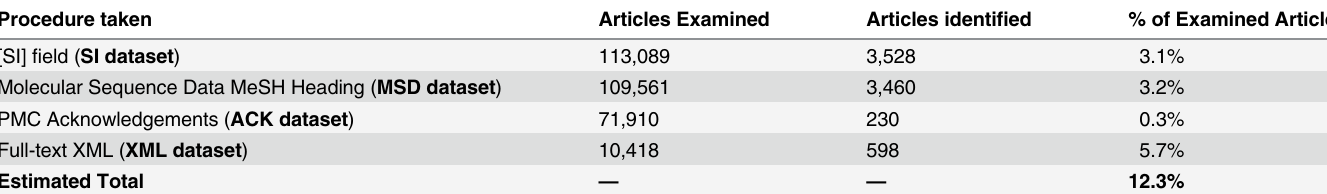
Table 7. Estimated Number of Articles with a Dataset Stored in a Known Repository.